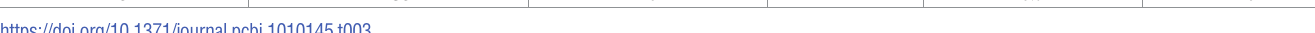
The local edge ranking of LEM informs the network finding step through the choice of seed network and additional edges to be used for network sampling. A user-chosen cutoff for the LEM score (LEM pld threshold) determines the edges in the seed network, and the user also specifies the number of additional edges to use in network construction. The seed edges and user-specified LEM edges together form the top-ranked LEM edges introduced in Table 1. The network neighborhood search around the seed network is constrained by net- work finding hyperparameter choices, the most important of which are topological con- straints, probabilities for adding or removing nodes and edges, the range of such operations to perform, the noise levels at which to compute the sequence of extrema in the data, and the maximum size of the networks allowed given in terms of the number of DSGRN parameter regions for the network. The maximum size must be limited for computational reasons; the number of DSGRN parameter regions scales combinatorially with the number of edges in the network. In the following, we limited ourselves to networks with at most 3000 DSGRN parameter regions. The network in Fig 3A has 2016 DSGRN parameter regions. As men- tioned in the Introduction, we are searching for core oscillator behavior, or strongly periodic signals that drive large-scale downstream oscillations. A key assumption is that a core oscil- lator is strongly connected, i.e. that there is a feedback path from every node to every other node in the network. We only sampled networks in the network finding step with this topo- logical property. The remainder of the network finding hyperparameters are shown in Table 4. Regarding noise levels, since we have reasonably smooth data we evaluated the sequence of extrema at a 0% noise level. For experimental data, this is not a reasonable choice, and a nonzero value will be chosen in our demonstration of the yeast cell cycle. The choice of seed network, the number of user-specified LEM edges, and the probabilities of adding and removing nodes and edges all depend on the level of trust in LEM output. For the synthetic network, we decided to put abso- ranked. In particular, we chose a seed network composed of all LEM edges with a probability greater than 0.98 and permitted only the addition of nodes and edges. We chose to explore a neighborhood of the seed network that permits a range of 2–10 additions from the next 40 (of 98 total) LEM-ranked edges, excluding self-repressing edges as mentioned earlier. In Fig 4, networks derived from the well ranked LEM edges (Fig 4A) show the oscillation and pattern match scores for one of the five simulations for the parameterization in Fig 3B. Networks derived from the poorly ranked LEM edges (Fig 4B) use the bottom 50 ranked edges in the same edge finding step along with an empty seed network to repeat the network finding step with the same hyperparameters.